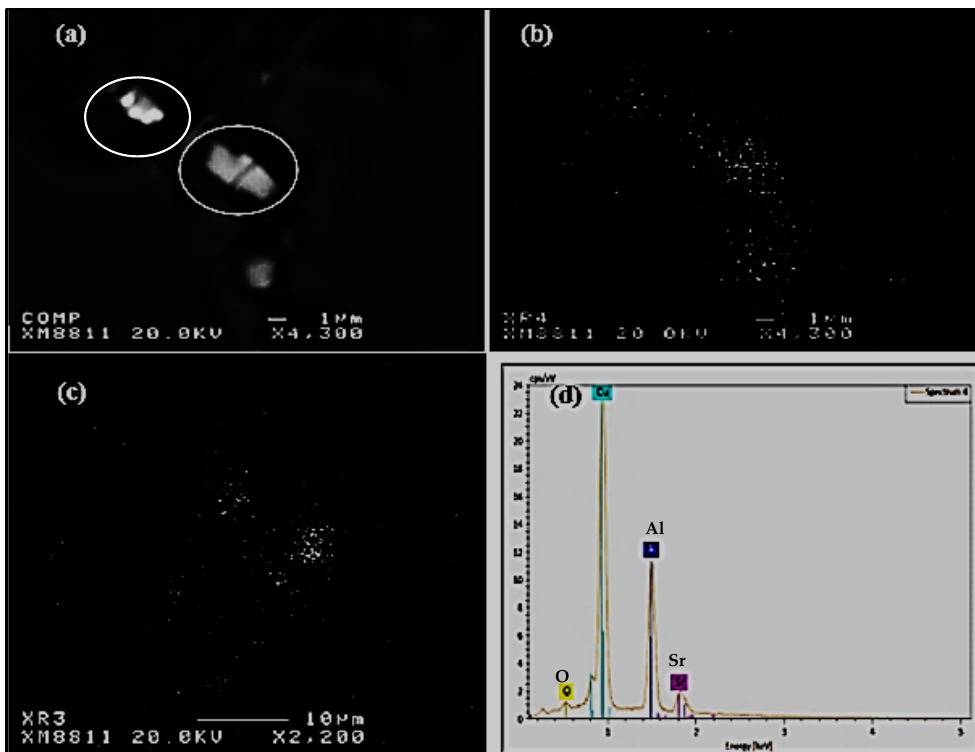
Figure 4. An example of SrO particles observed in the large section-marked X in Figure 1e: ( a ) backscattered electron image, ( b , c ) Sr and O distribution in ( a ), respectively, ( d ) EDS spectrum corresponding to circled particle in ( a ) revealing peaks due to Sr and O.